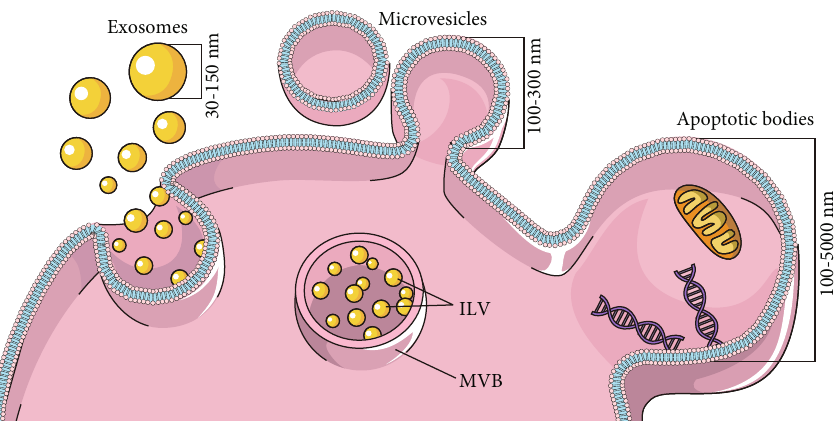
Figure 2: The interaction between bacteria, immune cells, and intestinal cells through EVs in gut. The schematic depicts the pathways by which OMVs derived from the member of microbiota take part in the hemostasis of intestines through various pathways. Bacteroides in virtue of HtrA packing in OMVs can facilitate its transmigration across polarized intestinal epithelial cells through the cleavage of the TJ and AJ. EVs from pathogenic bacteria can stimulate the production of interleukin-8 (IL-8) in IECs via the TLR5 and TLR4/MD-2 complex signaling pathway. OMVs from commensal bacteria containing peptidoglycans could colocalize with NOD1, trigger the NOD1 signaling pathway, and improve the expression of NF- κ B, IL-6, and IL-8. EVs derived from bacteria on bene fi ts of maintaining intestinal hemostasis re fl ected in increasing ZO-1 and claudin-14, decreasing claudin-2 in probiotic, and reducing the expression of IL-6 and TLR2- dependent EV internalization by DCs. EVs from IECs carrying αβ 6 activate LTGF β in intestinal tolerogenic DCs and Tregs. M ϕ -derived EVs can enhance survival of enterocyte through WNT function. Note: OMVs: out membrane vesicles; HtrA: high-temperature requirement A; TJ: tight junction; AJ: adherens junctions; GJ: gap junction; TLR4/5: Toll-like receptor; IL-8: interleukin 8;